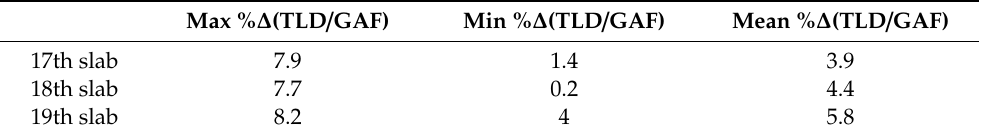
Table 5. Maximum, minimum and average percentage discrepancy for the 17th, 18th and 19th slab.